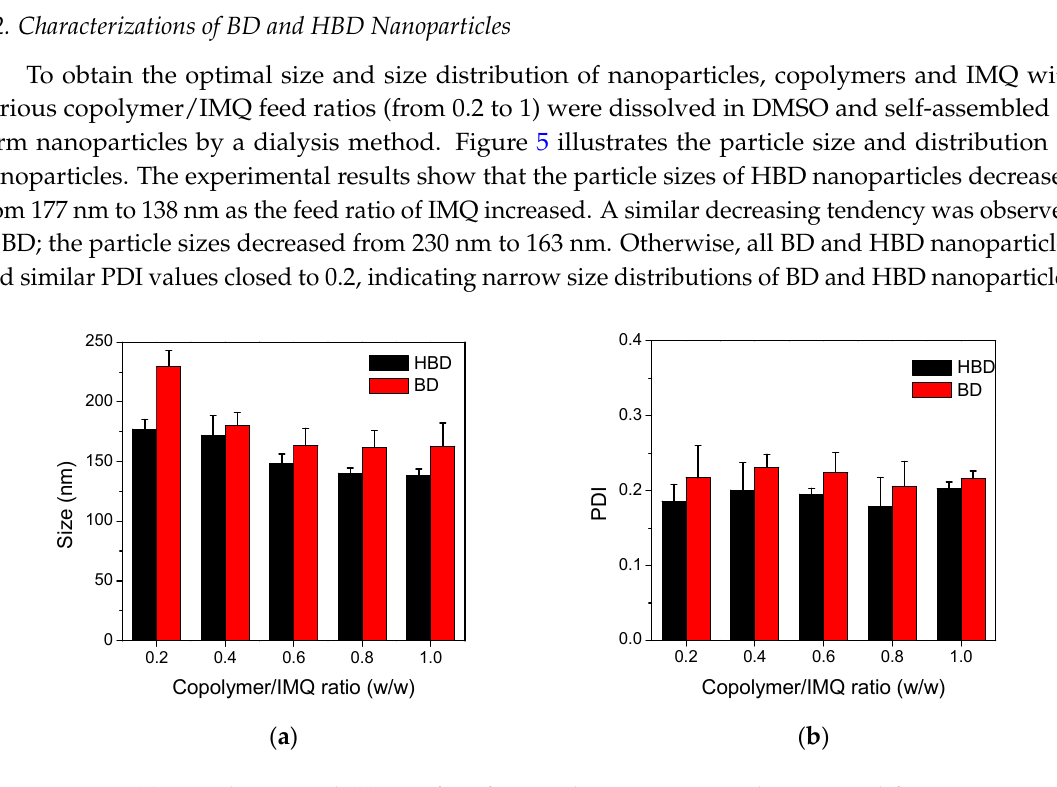
Figure 4. 1 H NMR spectrum of ( a ) HBD and ( b ) BD copolymers.